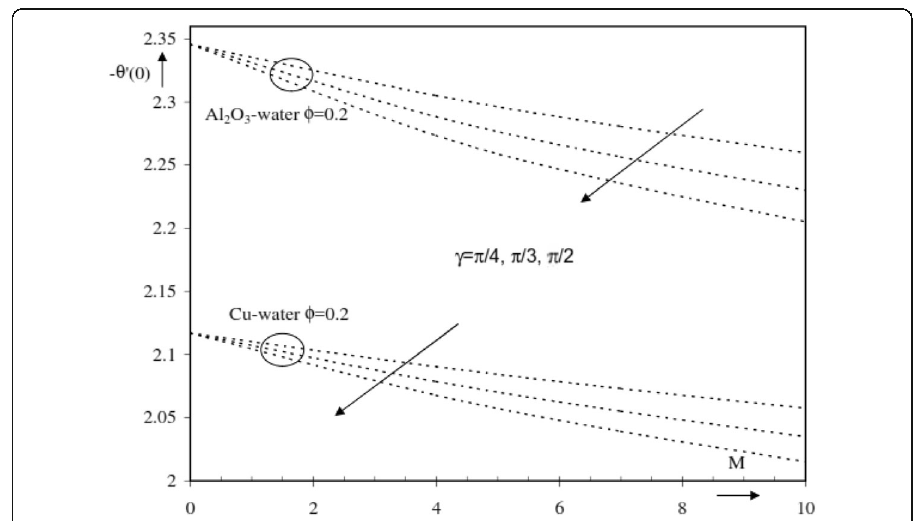
Fig. 19 Effects of M and γ on − θ ′ (0) for S = fw = 0.1 and λ = A = B = 0.5 for Cu-water and Al 2 O 3 − water